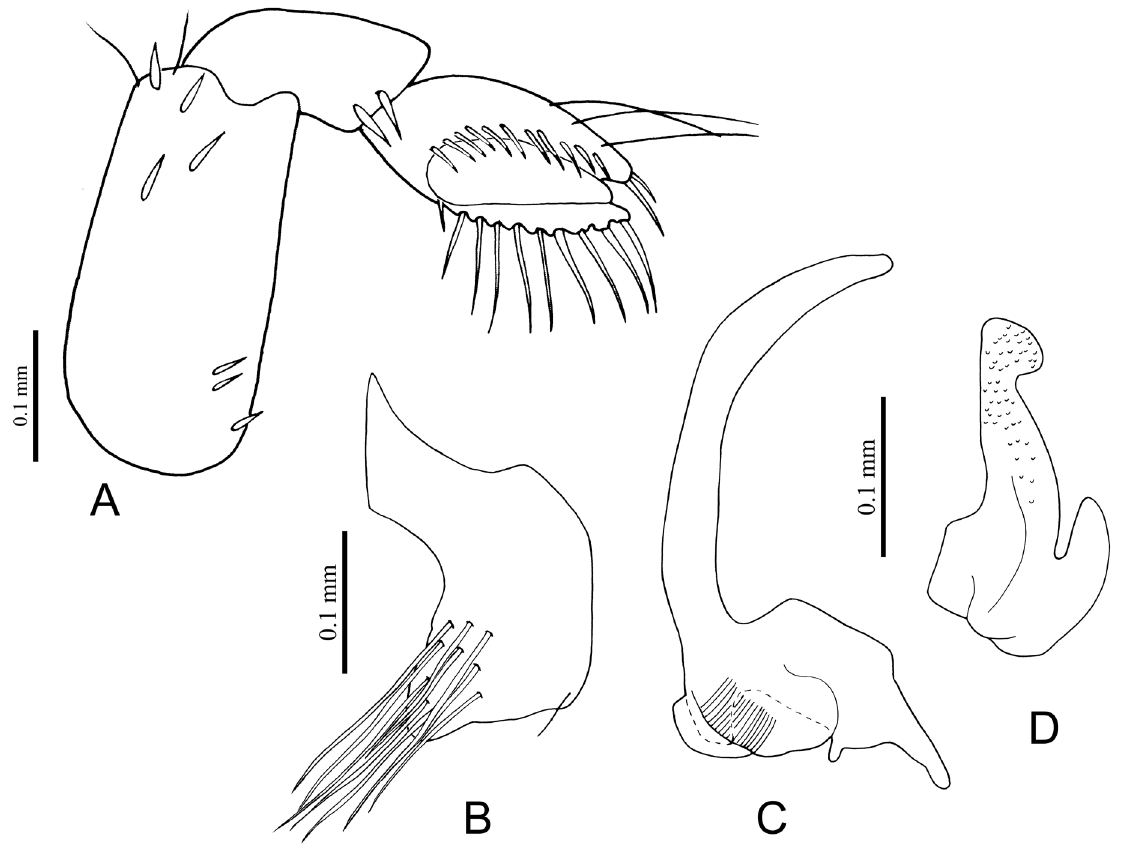
Fig. 20. Morphological features of Micronecta haliploides Horváth, 1904, ♂ (ZVNU). A . Fore leg. B . Free lobe. C . Right paramere. D . Left